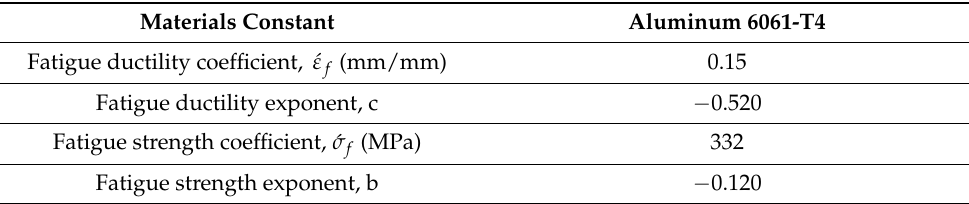
Table 3. Fatigue materials constants for aluminum 6061-T4